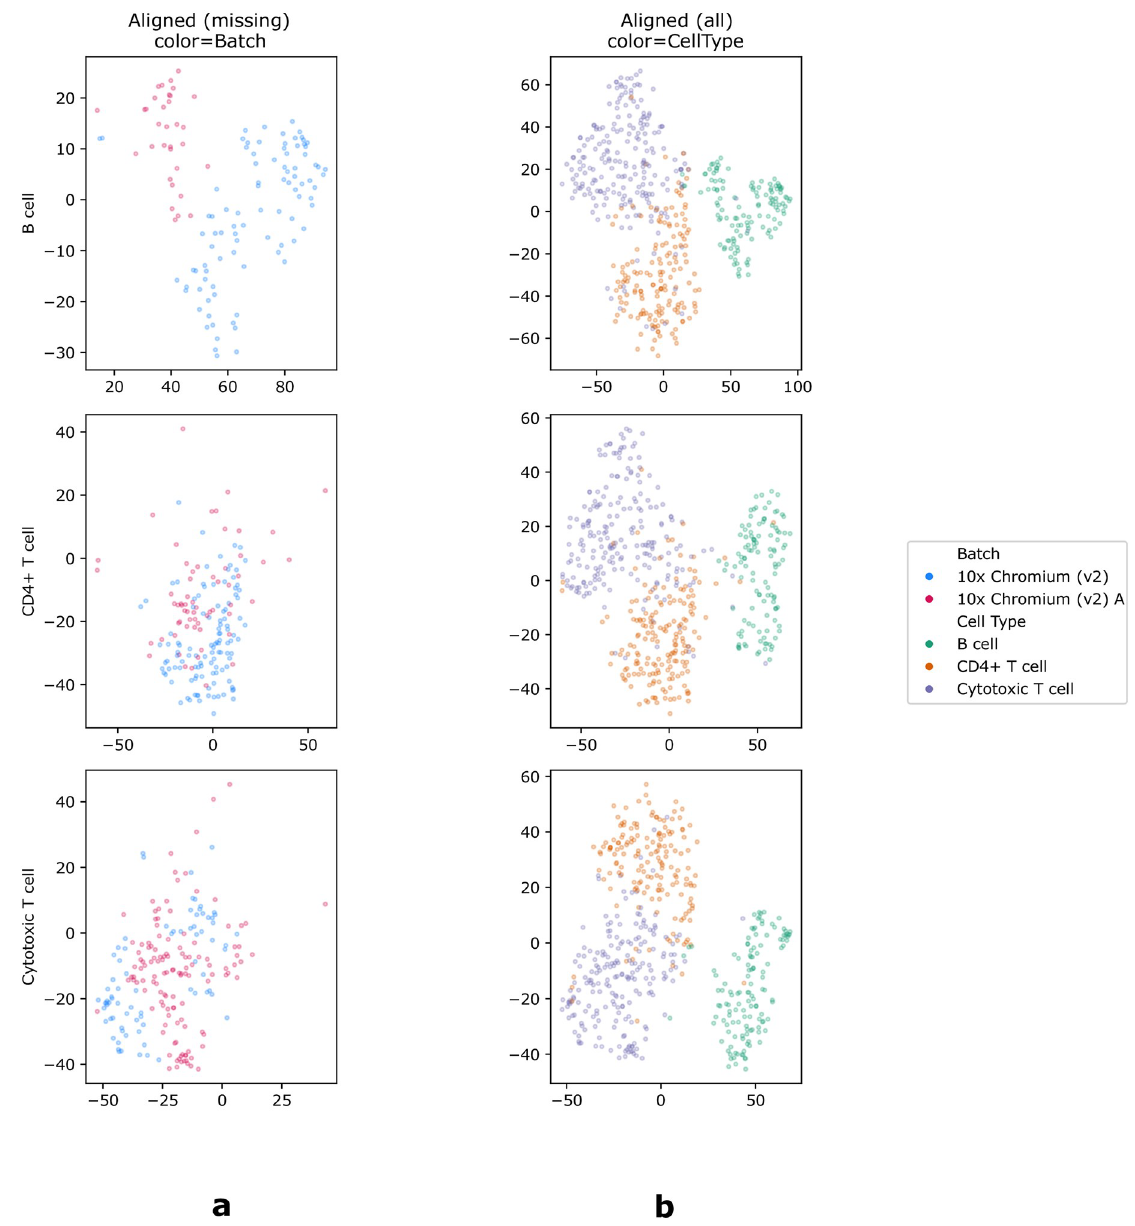
Fig 5. Embedding (t-SNE) visualization from the PBMC:10x Chrom . (v2) A ! 10x Chrom . (v2) task using SCIPR-gdy showing generalizability to new cells. In each alignment task (rows), a different cell type is completely held-out from the source set. The model is then fitted to align the source and the target, and this fitted model is then used to transform the full source set, including the held-out cell type which the model did not see in the source set used for fitting. The first column (a) shows just the held-out cell type colored by batch, after applying the fitted SCIPR-gdy model to align it. The second column (b) shows all of the data after applying the fitted model, colored by cell type.